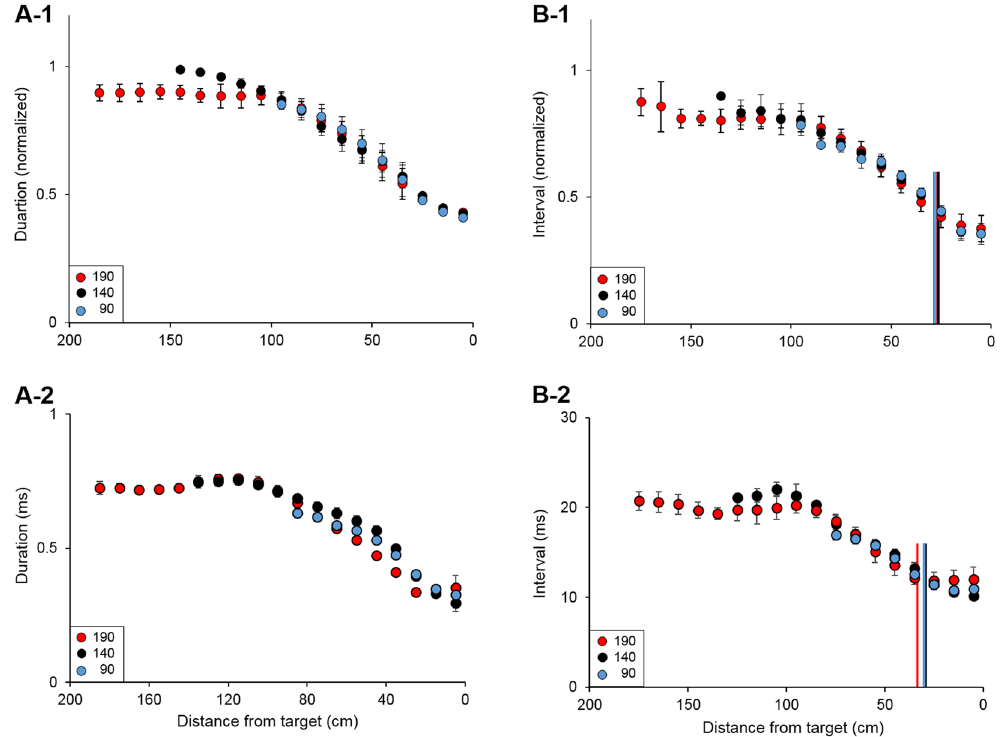
Figure 3. Bats maintained a fixed approach phase during flight. ( A ) When flying to a closer target (blue or black circles) the bats started their approach ‘in step’, meaning that signal duration at takeoff was appropriate as if the bat reached this distance at flight from a greater distance. Data are aligned to landing (distance ‘0’), shown are mean ± se, smoothed over a three-window period. A-1 All individuals, normalized data. A-2 An example of one individual. ( B ) The same strategy was evident with regards to emission rate and buzz initiation distance (vertical lines in panels B1-2, colours encoding is the same as the circles) – intervals between signals at the beginning of flight for a closer target were ‘in step’ as if the bat reached that distance from a farther starting point. Buzz was initiated at a fixed distance from target regardless of total flight distance. B-1 shows normalized data of all bats (normalization is the same as in Fig. A), B-2 is an example of one individual. See also Supplementary Figs S3 and S5.